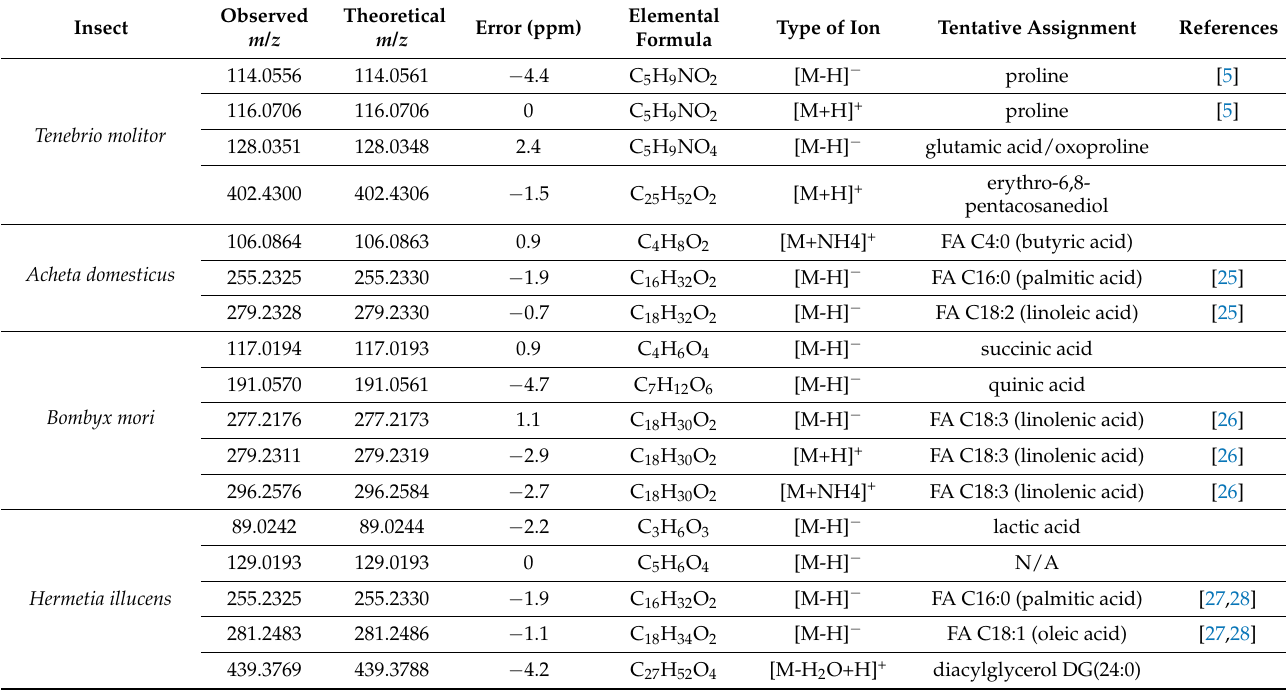
Table 1. List of discriminant ( ± ) DART-HRMS compounds that enable the identification of the four species of insects. The observed m / z , theoretical m / z , error (ppm), elemental formula, type of ion, and tentative assignment are listed.